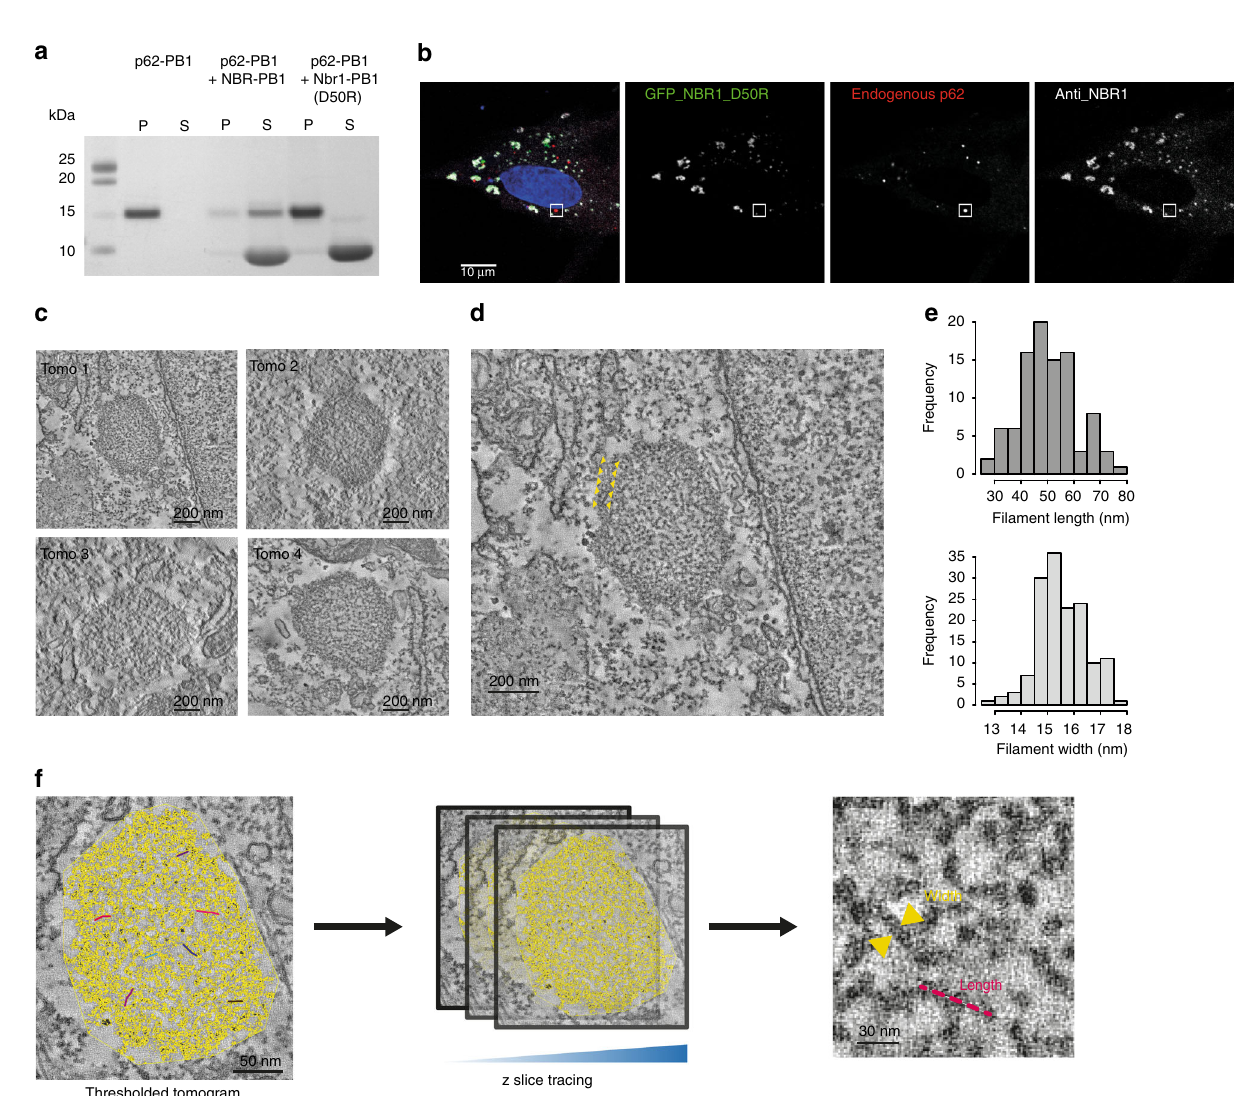
Fig. 5 CLEM visualization of p62 bodies in cells. a Effect of human NBR1-D50R mutation on p62 fi laments. SDS-PAGE analysis of pelletation assay showing that p62-PB1 fi laments are not disrupted by NBR1 – PB1 with a D50R mutation (P = pellet; S = supernatant). Source data are provided as a Source Data fi le. b Representative confocal fl uorescence images showing NBR1 (green) and endogenous p62 (red) in RPE1 cells. Co-localization analysis of fi xed RPE1 cells stably expressing NBR1(D50R) shows no overlap of NBR1(D50R) with p62 bodies. c Representative electron tomogram slices of p62 bodies localized by CLEM. d Enlarged view of a representative tomogram slice from the highlighted p62 body in ( b ) reveals the fi lament-like meshwork of p62 bodies. Note the apparent phase separation of the p62 body from the cytosol. The ring of increased density surrounding the bodies is indicated by yellow arrows. e Distribution of estimated fi lament length and width from tracing in thresholded tomograms. Source data are provided as a Source Data fi le. f Schematic illustration of width and length measurements performed in thresholded tomograms (yellow